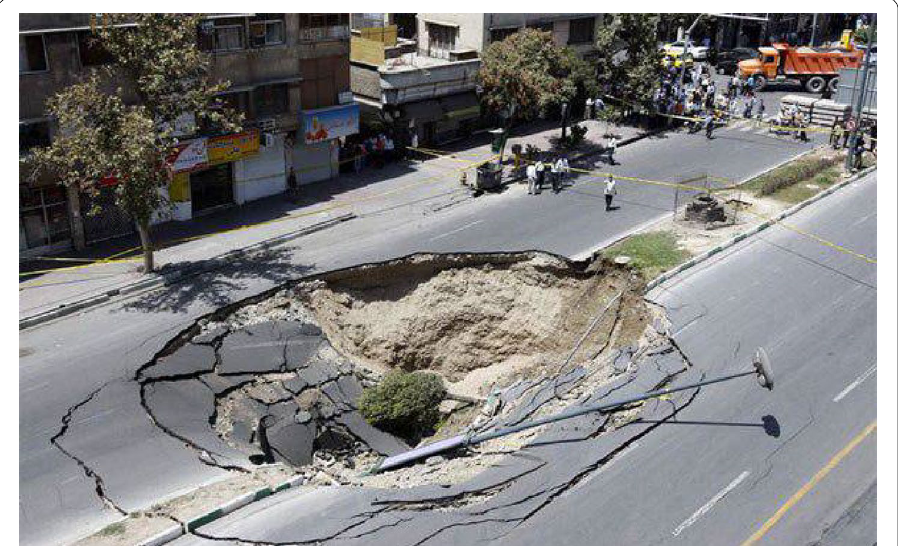
Fig. 21 Collapsed aqueduct near Navab Square, Tehran (east of